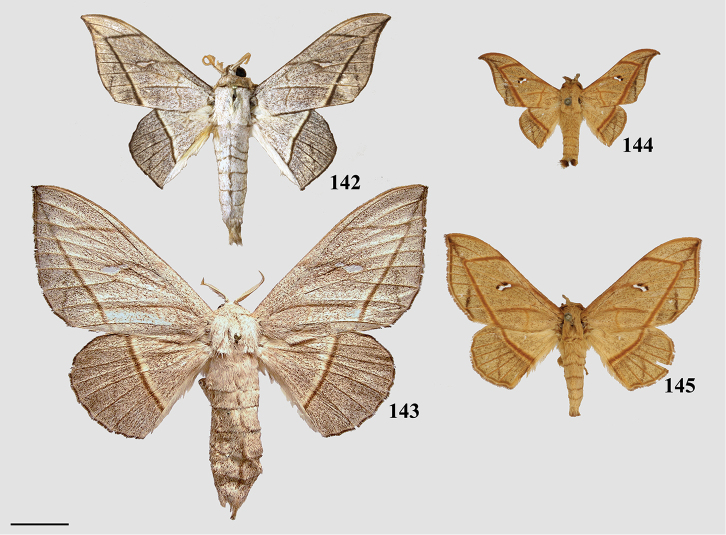
Adult specimens of type species of genera belonging to Cicinninae: Bedosiini. 142Bedosiafraterna, male (MGCL) 143B.fraterna, female [photo P Collet] (MNHN) 144Bedosialloforbesi, male [reused with permission from St Laurent et al. (2018a), Systematic Entomology] (NHMUK) 145B.forbesi, female [reused with permission from St Laurent et al. (2018a), Systematic Entomology] (NHMUK). Scale bar: 1 cm.